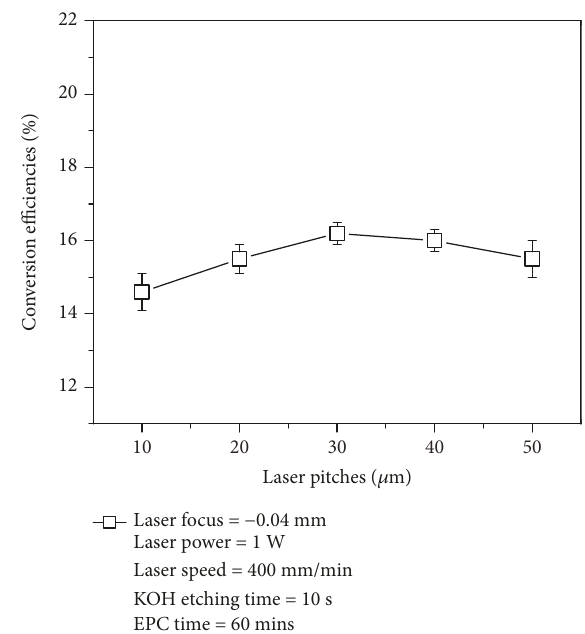
Figure 6: Conversion e ffi ciency vs. laser line pitch curve of SPMSCs with a B-BSF seed layer and EPC contact layer as the rear